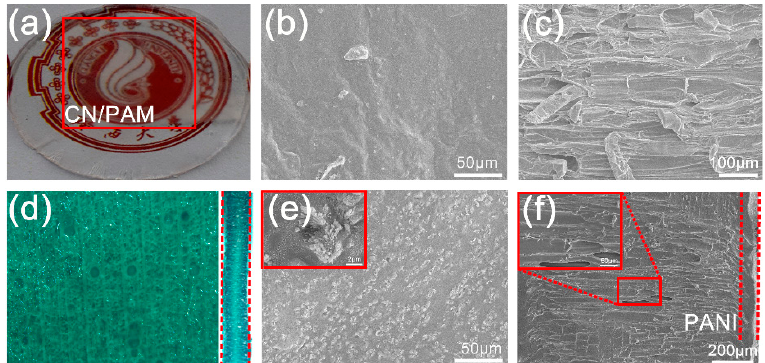
Figure 2. The morphology of CN/PAM and CPP composite hydrogel. ( a ) Digital photograph of CN/PAM; ( b ) SEM image of CN/PAM (cross section); ( c ) SEM image of CN/PAM (longitudinal section); ( d ) digital photograph of the cross (left) and longitudinal (right) sections of the CPP composite hydrogel prepared with 60 cycles; ( e ) SEM images of the CPP composite hydrogel (cross section); ( f ) SEM images of the CPP composite hydrogel (longitudinal section). Polymers 2020 , 12 , x FOR PEER REVIEW